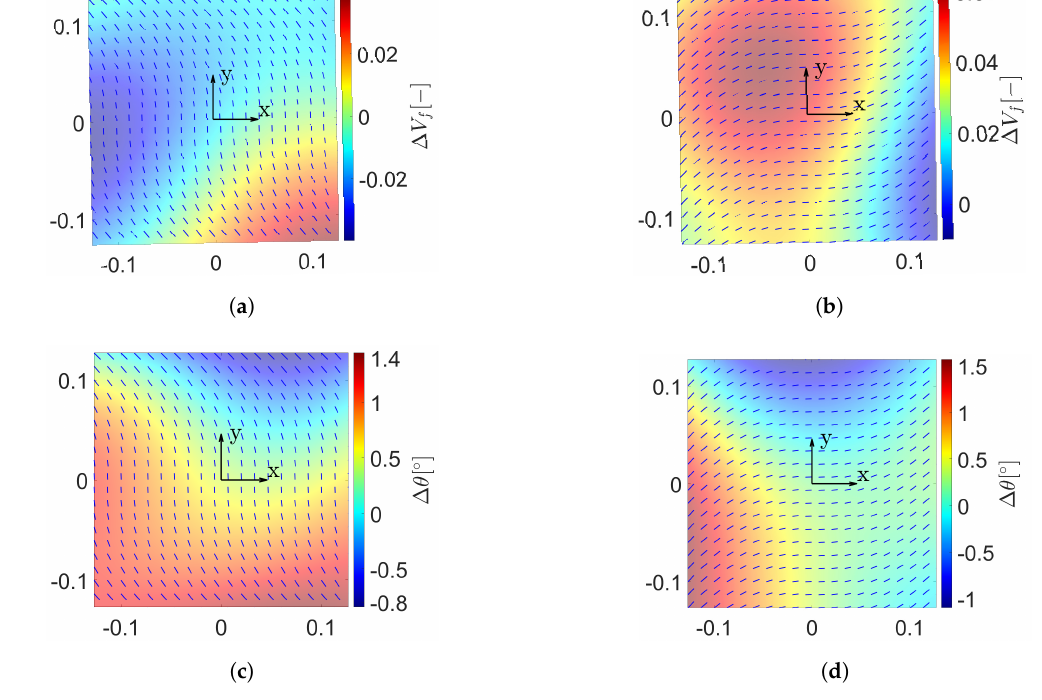
Figure 7. ( a ) Fibre volume fraction ( ∆ V f ) random field over a [ 90 + < 0,45 > ] . ( b ) ∆ V f random field over a [ 0 + < 0,45 > ] ply. ( c ) Misalignment field over a [ 90 + < 0,45 > ] ply. ( d ) Misalignment field over a [ 0 + < 0,45 > ] ply. These random fields are generated by means of the Karhunen-Loève expansion. The stochastic fields represent the fibre volume fraction and has a mean value ˜ V f = 0.60 = 0.05 and fibre misalignments of null mean and standard deviation and a standard deviation σ V f σ θ = 1.5 ◦